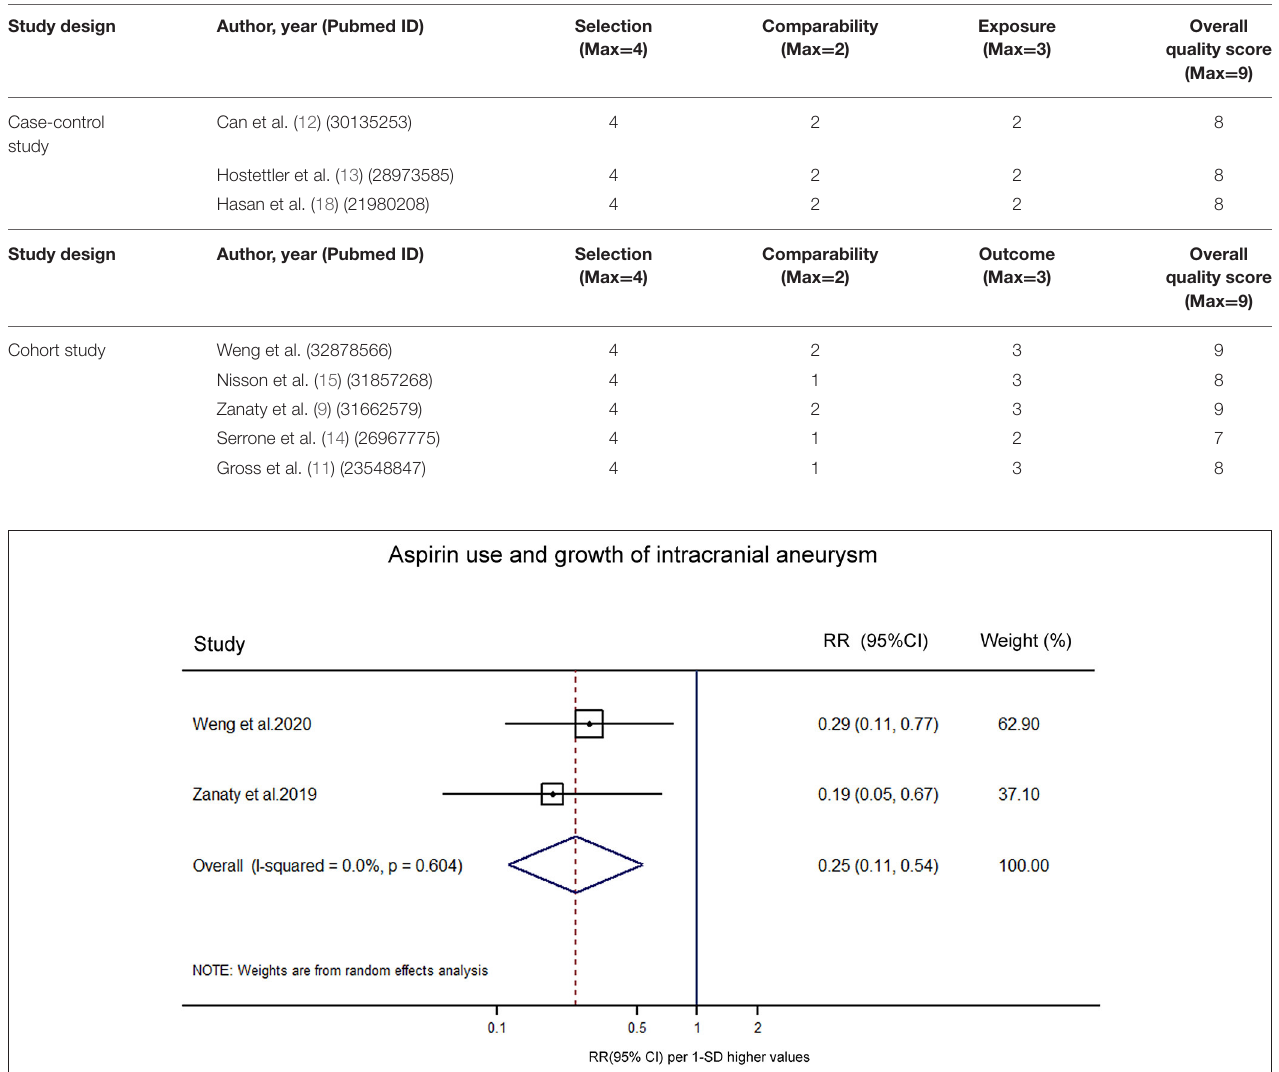
TABLE 2 | Newcastle-Ottawa scale for assessing the quality of included studies.